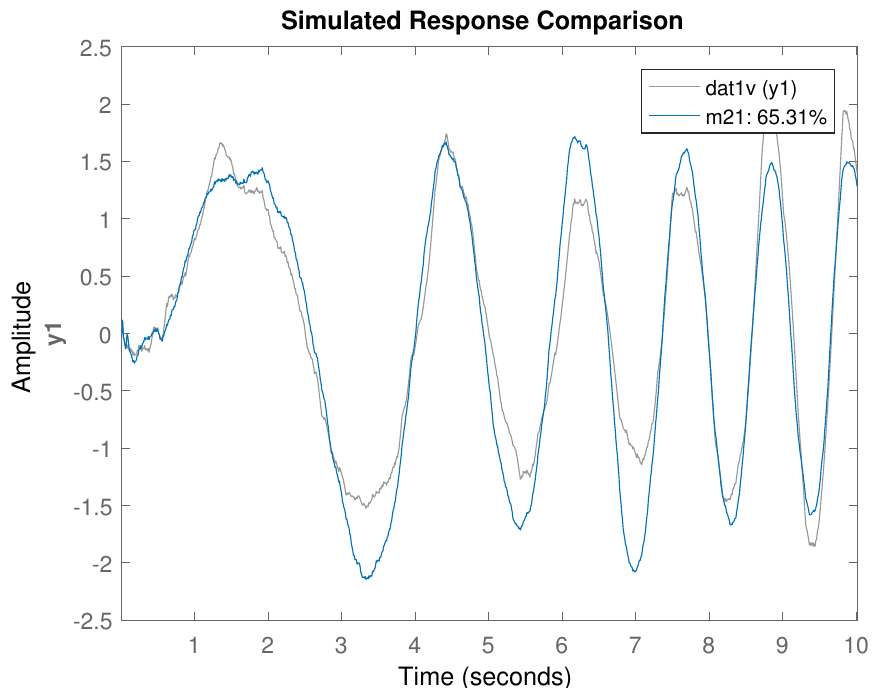
Figure 4. Comparisonbetween the linear Box–Jenkins model of the spool valve and the validation data-set.